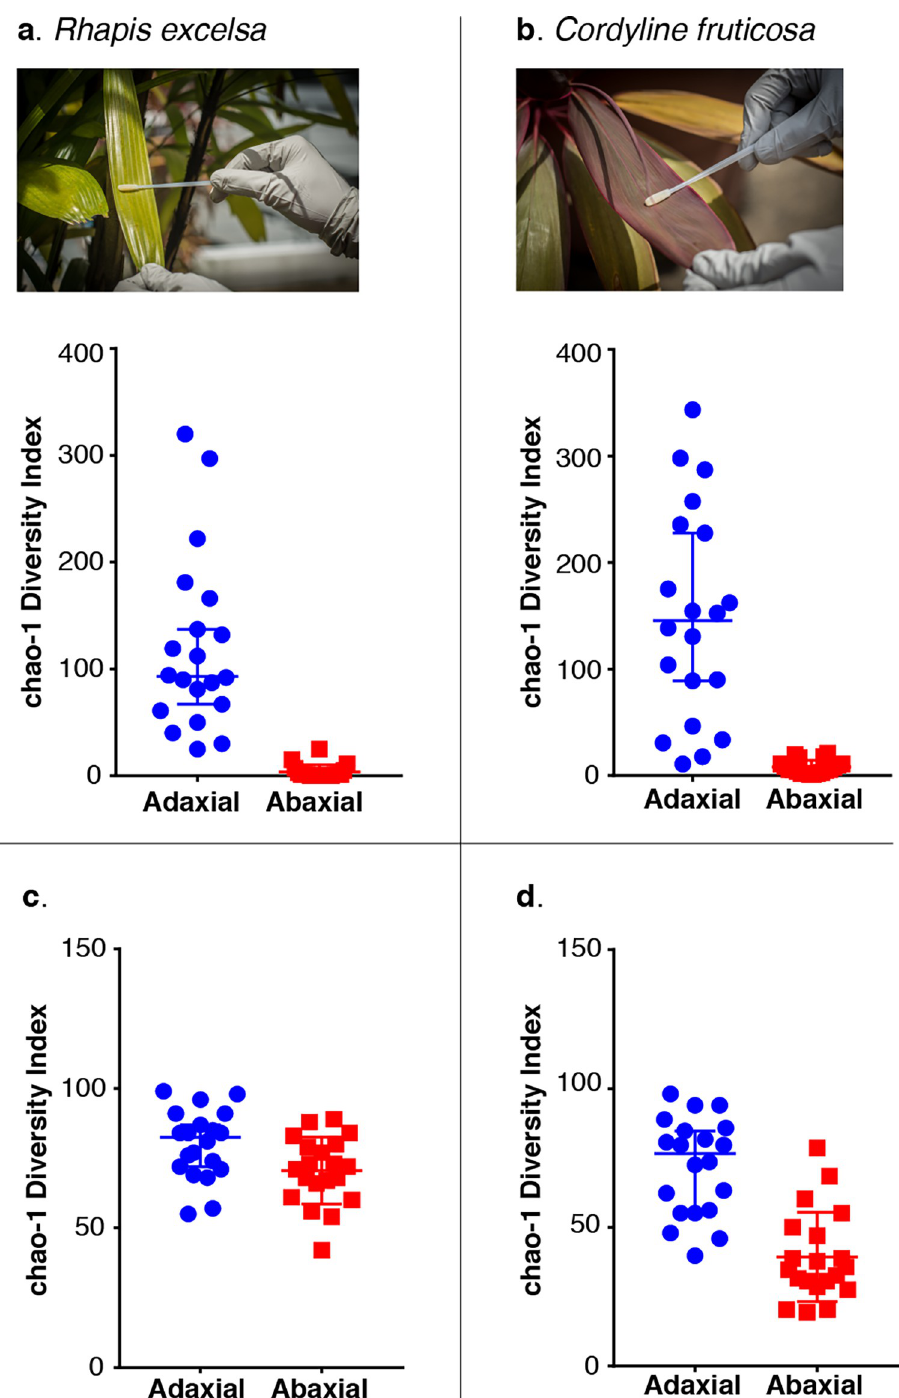
Fig 2. Dot plots of species richness using Chao-1 index of the adaxial and abaxial leaf surface. Approximately 95– 98% fewer in bacterial species were observed on the abaxial leaf surface of (a) R . excelsa and (b) C . fruticosa in contrast to their adaxial surface. There was also a decrease in fungal species observed on the abaxial surface of (c) R . excelsa and (d) C . fruticosa . All four dot plots showed statistically significant differences between the adaxial and abaxial surface using Mann Whitney test (S2 Table). The photographs were taken by Balakrishnan N.V. Premkrishnan.